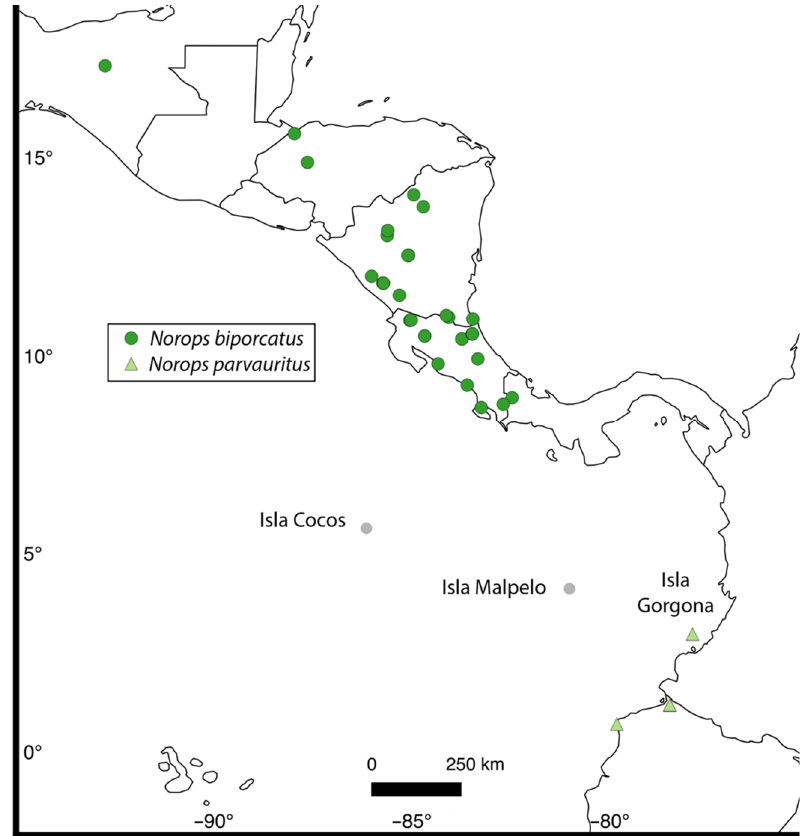
Figure 3. Map of the Eastern Tropical Pacific (ETP) with the three islands in this study. Mainland sampling localities for Norops biporcatus and N. parvauritus included in the molecular phylogeny are also shown.